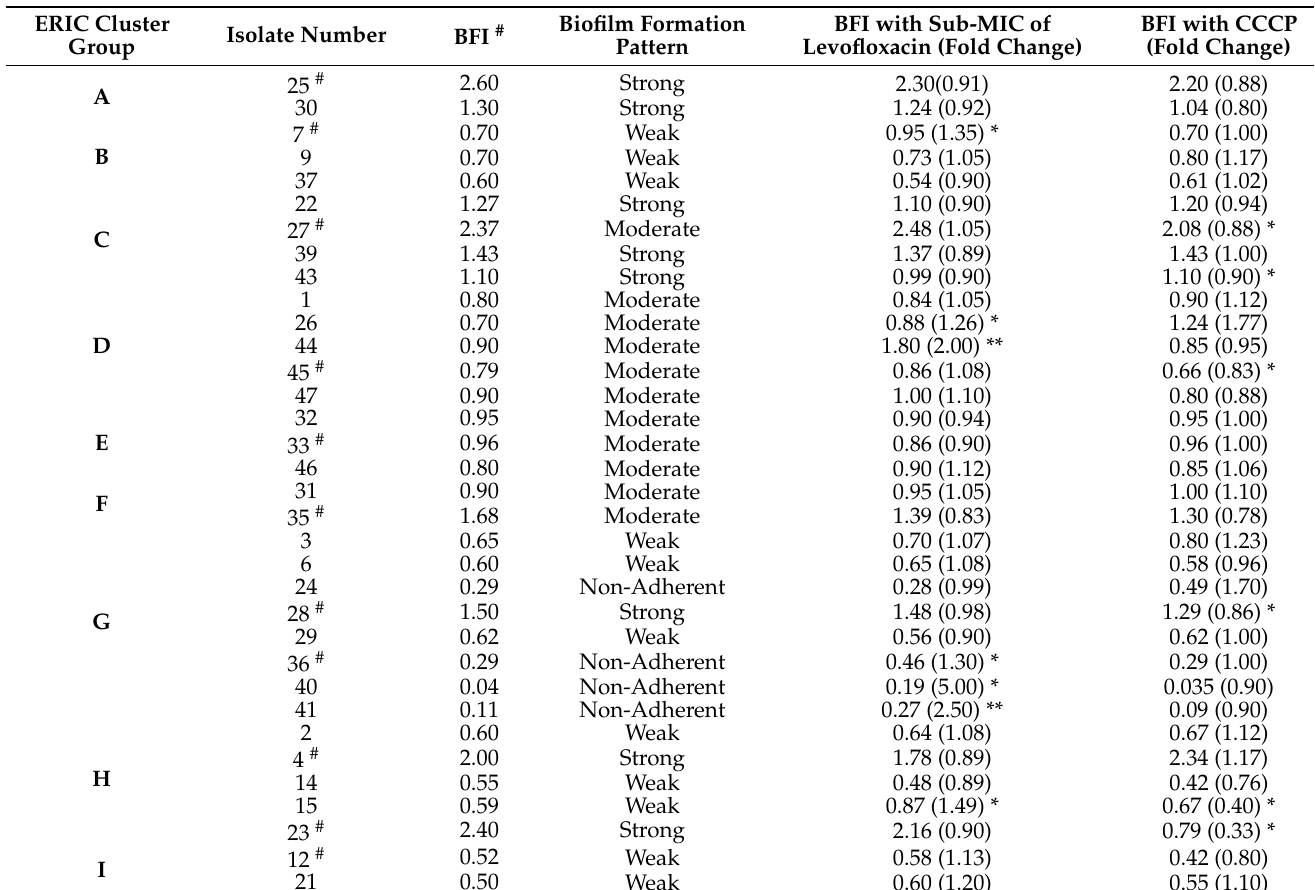
Table 3. Biofilm formation potential by Acinetobacter baumannii isolates and the effect of efflux